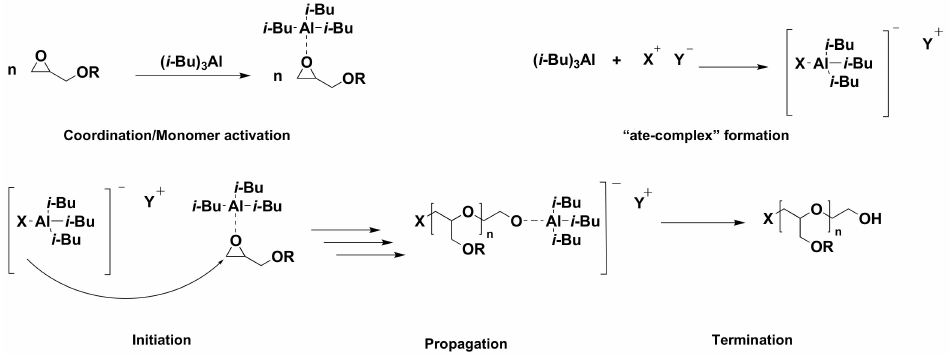
Figure 7. Reaction mechanism of activated monomer polymerization technique. Adapted with permission from ref. [9]. Copyright 2016 American Chemical